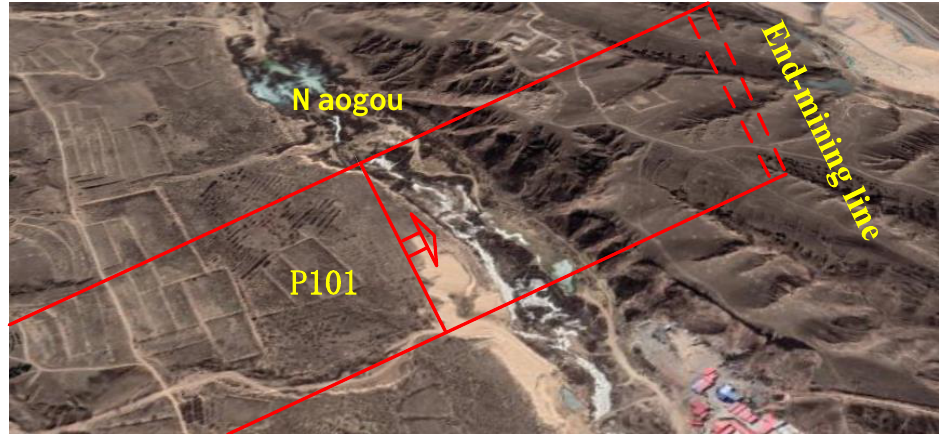
Figure 1. Distribution of working face P101 and gully.